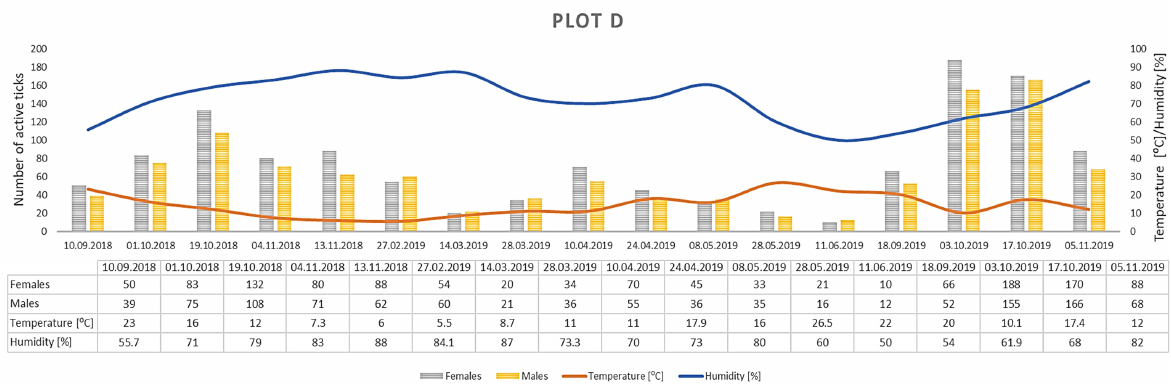
Figure 5. Abundance and seasonal activity of Dermacentor reticulatus adults in research plot C and weather conditions prevailing during tick collection. Predominance of active ticks in spring.